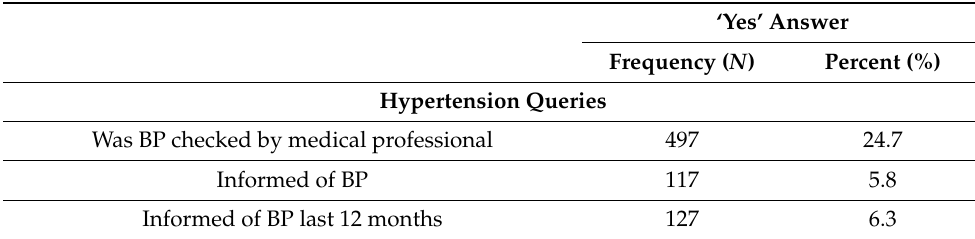
Table 4. Queries about hypertension, diabetes and their